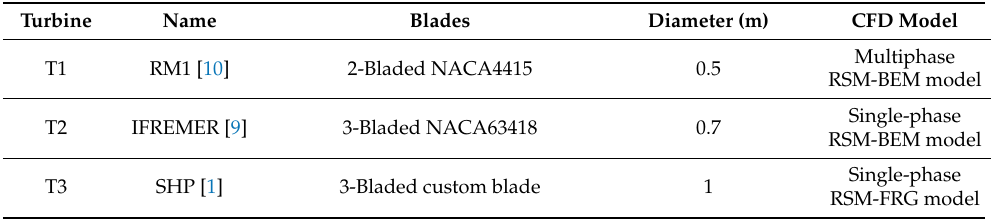
Table 2. Turbines modelled in